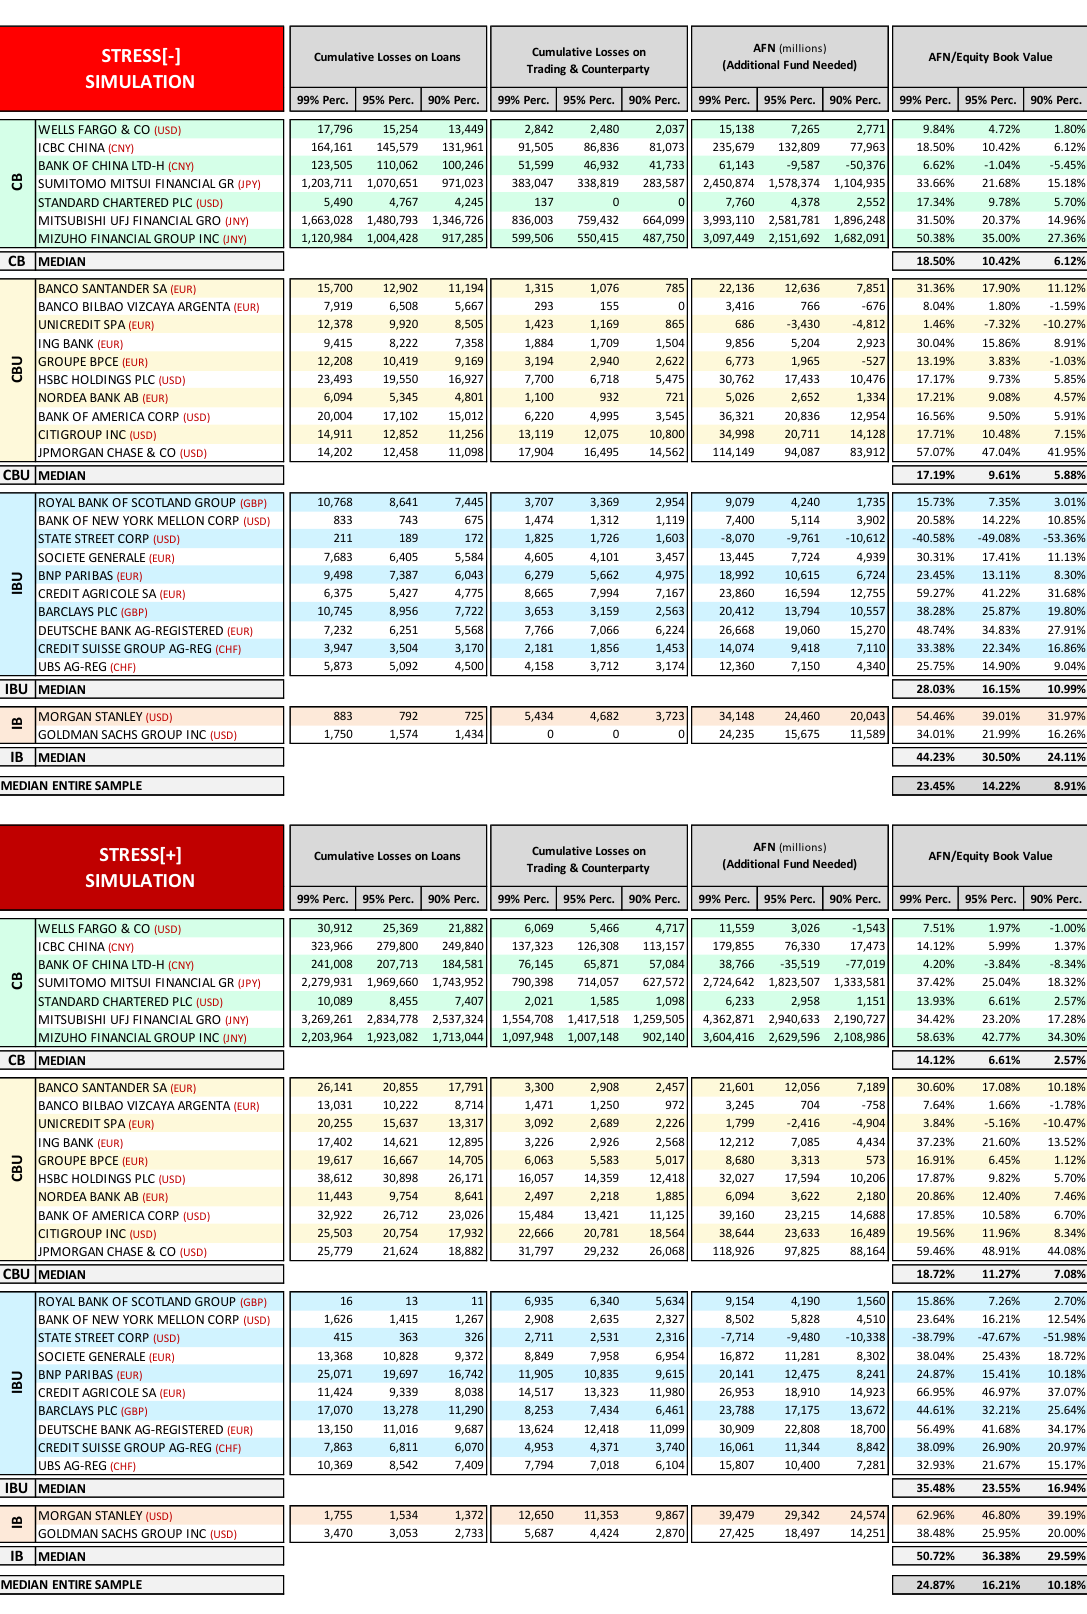
Figure A6. 2014 Stress test exercise: credit/market cumulative losses and funding shortfall.